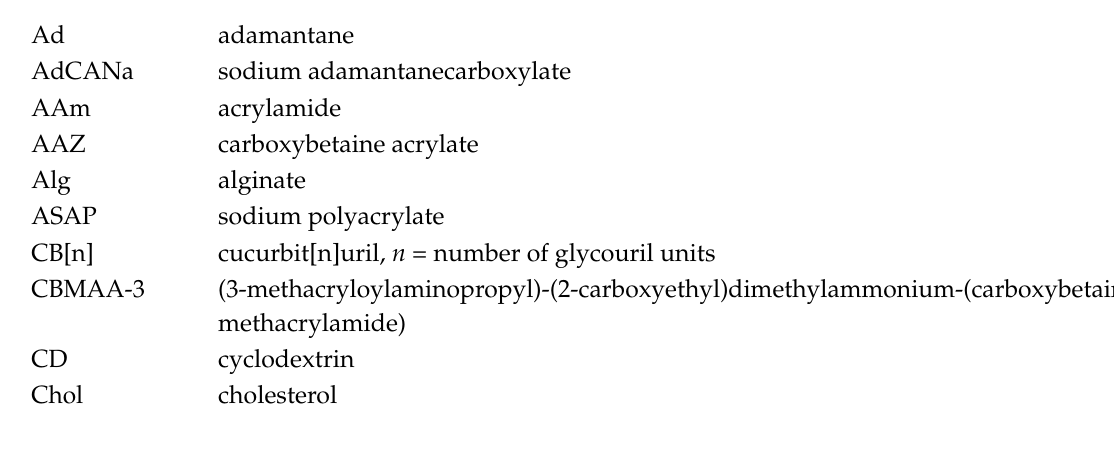
figure panels. X. X. Zhu organized the topics, contributed to the discussion of the contents and corrected the